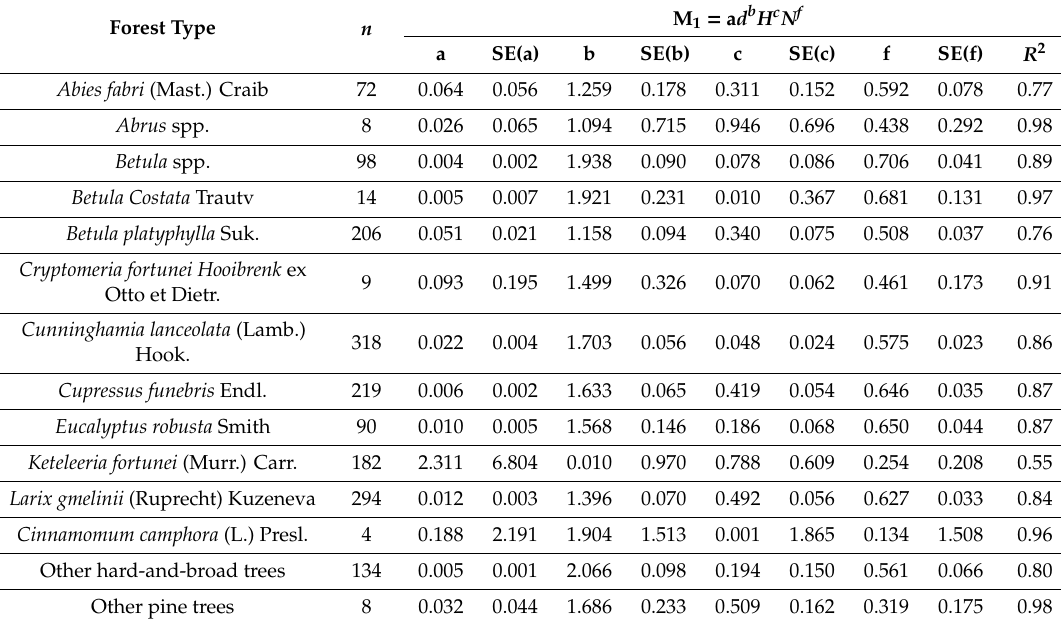
Table 4. Fitting results for model